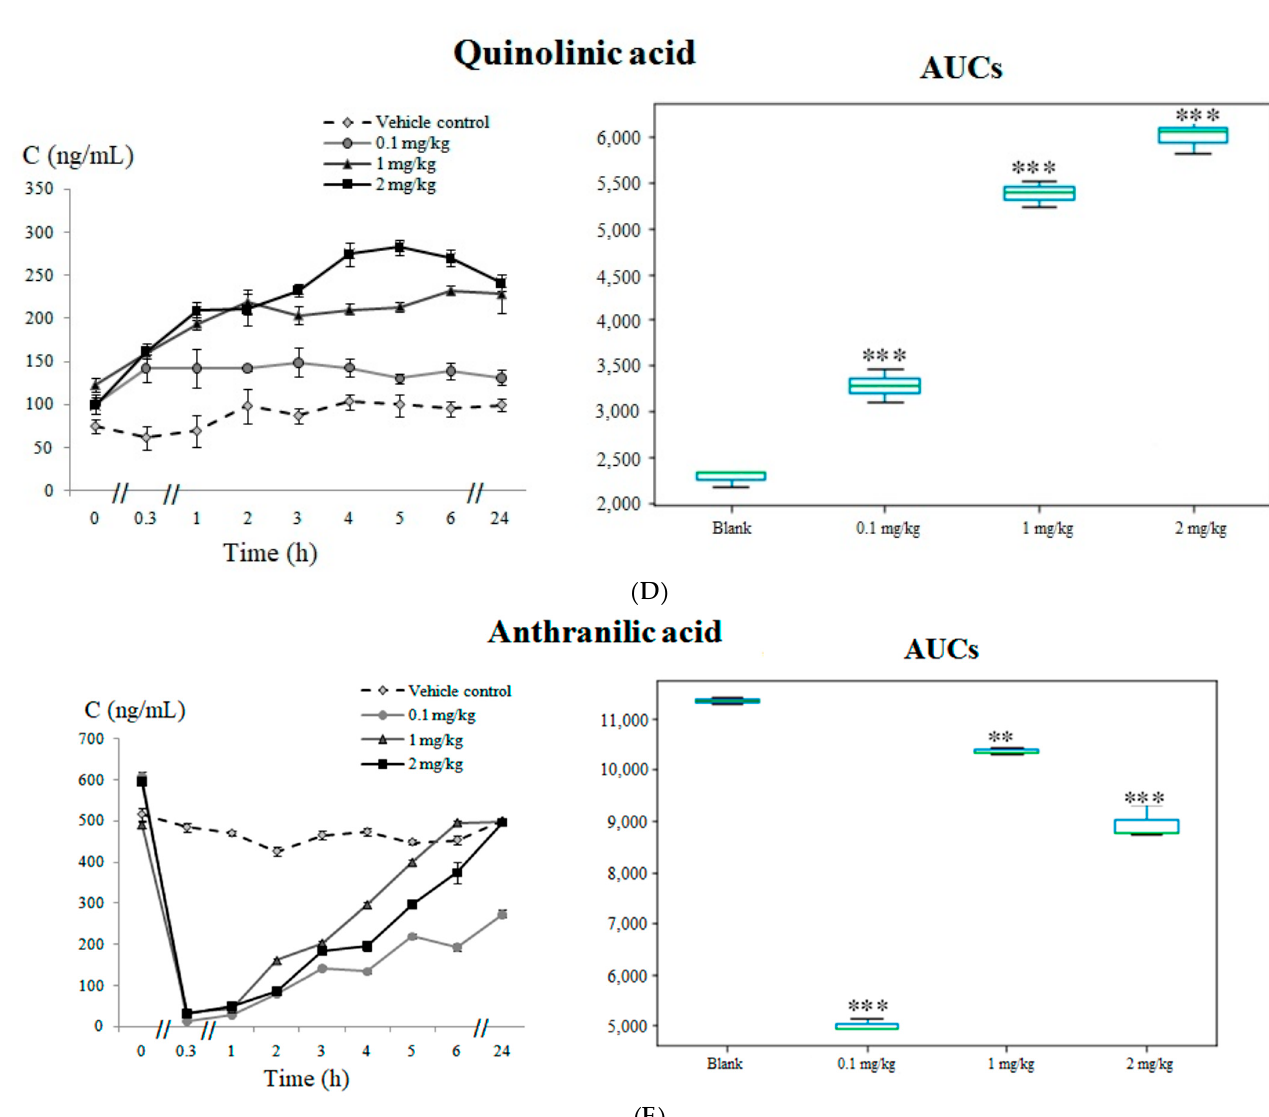
Figure 4. Metabolites related with the kynurenine pathway: ( A ) time-concentration profile and boxplots of the AUC for kynurenine, ( B ) time-concentration profile and boxplots of the AUC for kynurenic acid, ( C ) time-concentration profile and boxplots of the AUC for xanthurenic acid, ( D ) time-concentration profile and boxplots of the AUC for quinolinic acid and ( E ) time-concentration profile and boxplots of the AUC for anthranilic acid. Statistically significant differences in the AUCs between the vehicle control versus the test groups are marked with asterisks as ** p < 0.01 and *** p < 0.001.